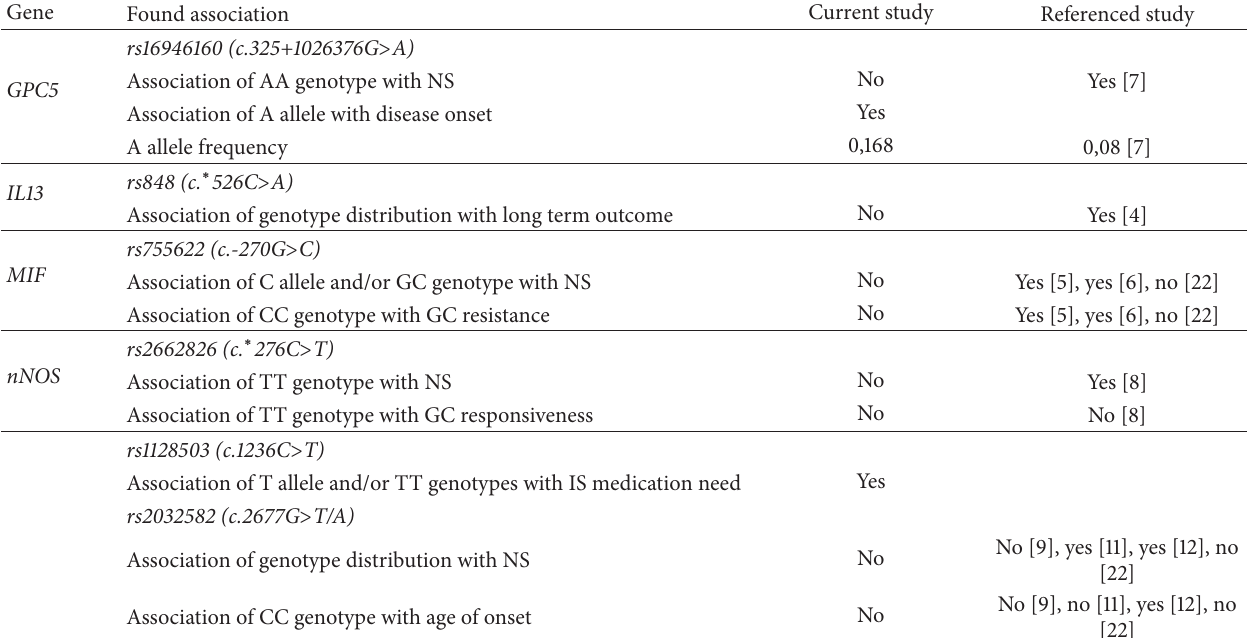
Table 7: Comparison between the found associations of the analyzed SNPs in this study and in previous studies. Gene Found